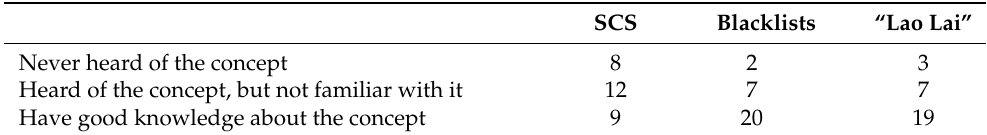
Table 3. Different knowledge about the concepts of SCS, blacklists and “Lao Lai” among the partici- pants. Never heard of the concept 8 2 3